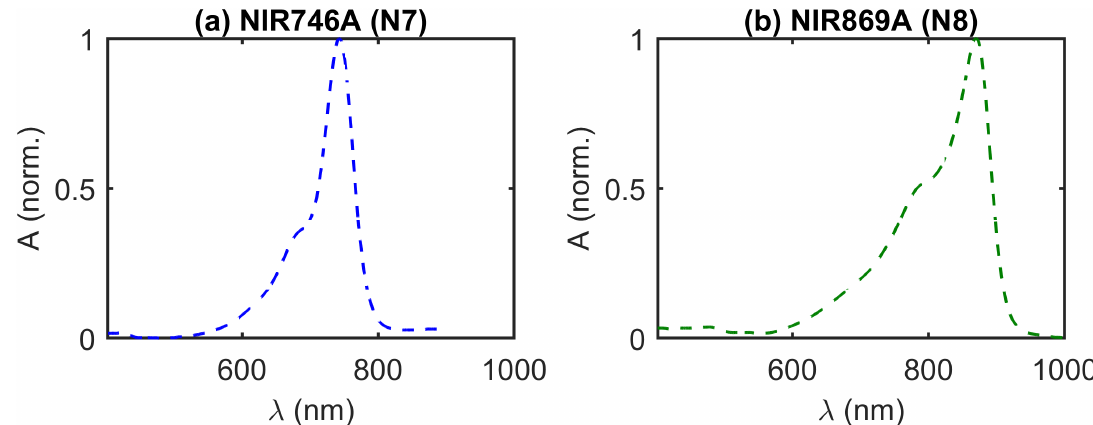
Figure 3. Expected spectral features of near-infrared dyes in water, provided by the manufacturer (QCR Solutions, Palm City, FL, USA). [37] ( a ) Normalized Absorbance (A) versus wavelength ( λ ) of NIR746A dye (N7). ( b ) Normalized A of NIR869A dye